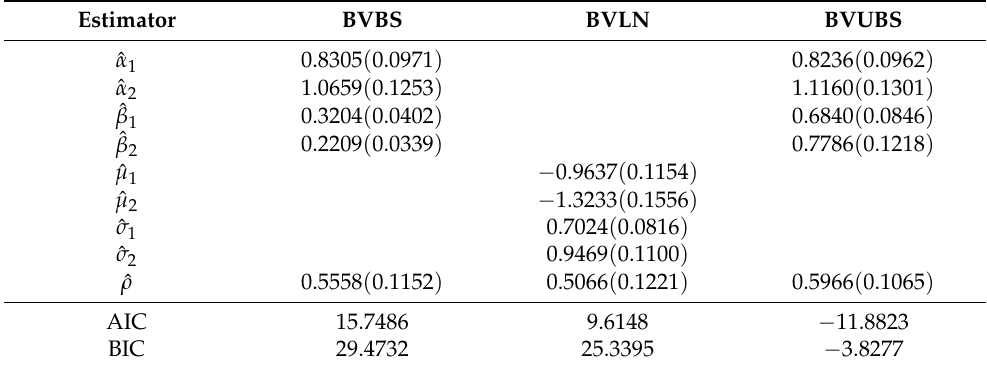
Table 1. Estimation of the parameters with their standard errors for the BVBS, BVLN, and BVUBS dis-